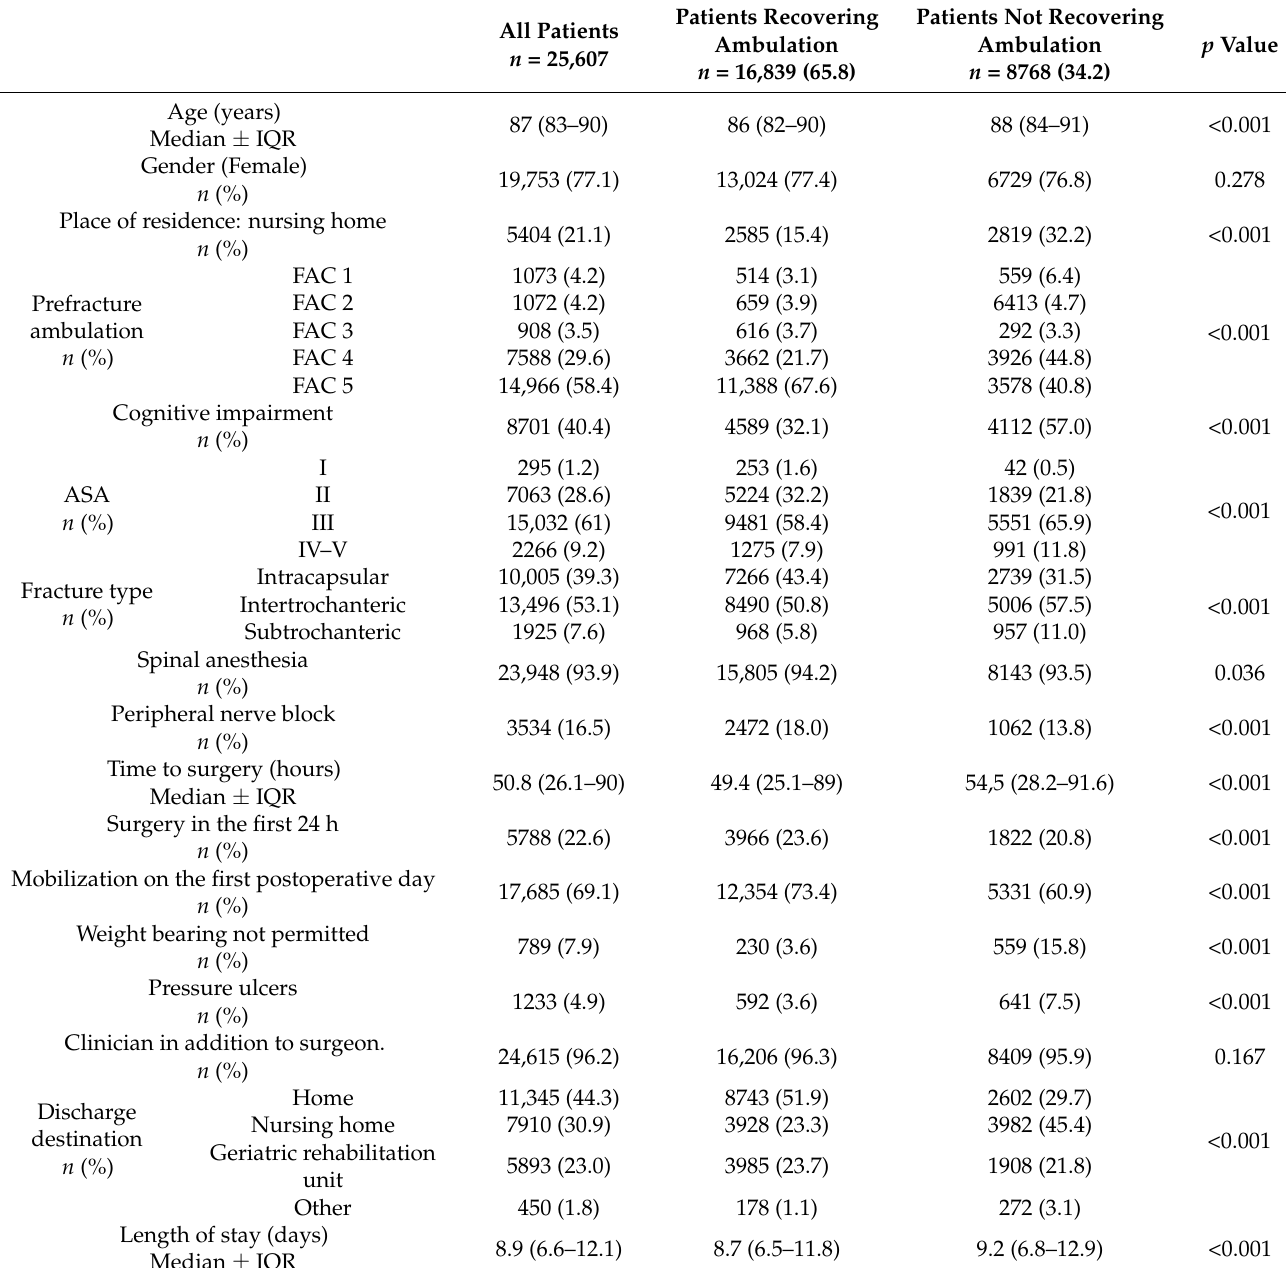
Table 2. Baseline characteristics of the global sample and according to the presence or absence of gait recovery. Univariate